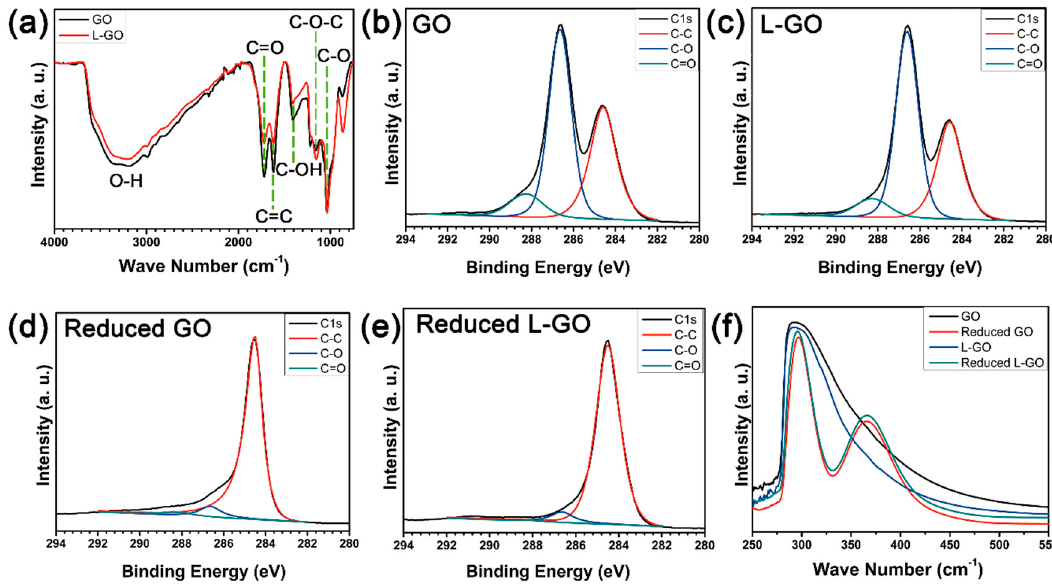
Figure 4. ( a ) FTIR spectra of GO and L-GO films. XPS C1s spectra: ( b ) GO, ( c ) L-GO, ( d ) reduced GO, and ( e ) reduced L-GO. ( f ) UV-VIS absorption spectra of GO and L-GO films before and after